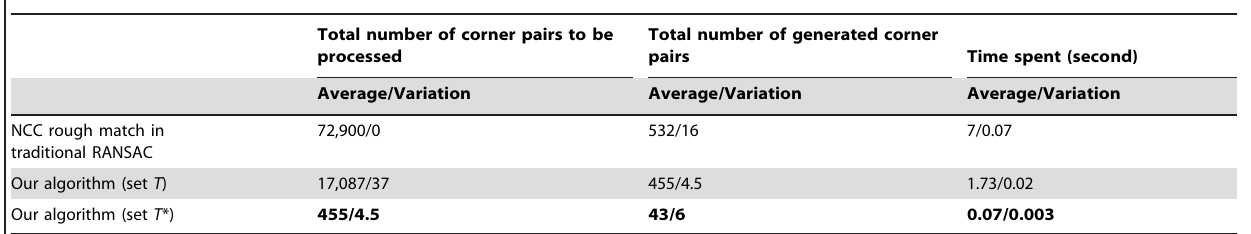
Table 3. Efficiency comparison between traditional RANSAC and our algorithm